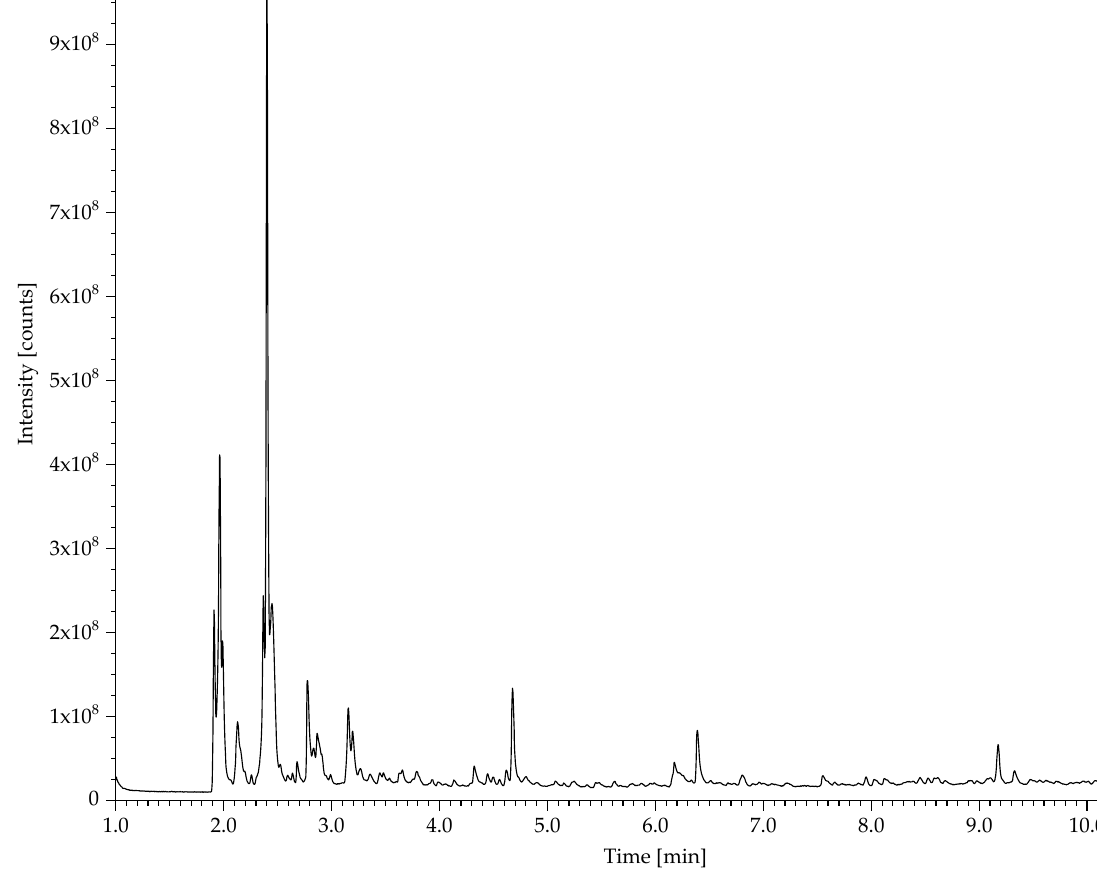
Figure 6. Pyrogram of sample 194 ( a ) and a zoomed ‐ in view of the same pyrogram ( b ).